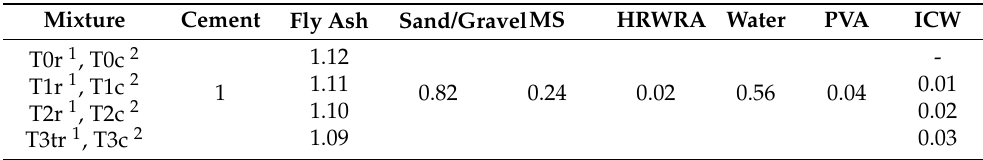
Table 2. Relative mass mix proportions.